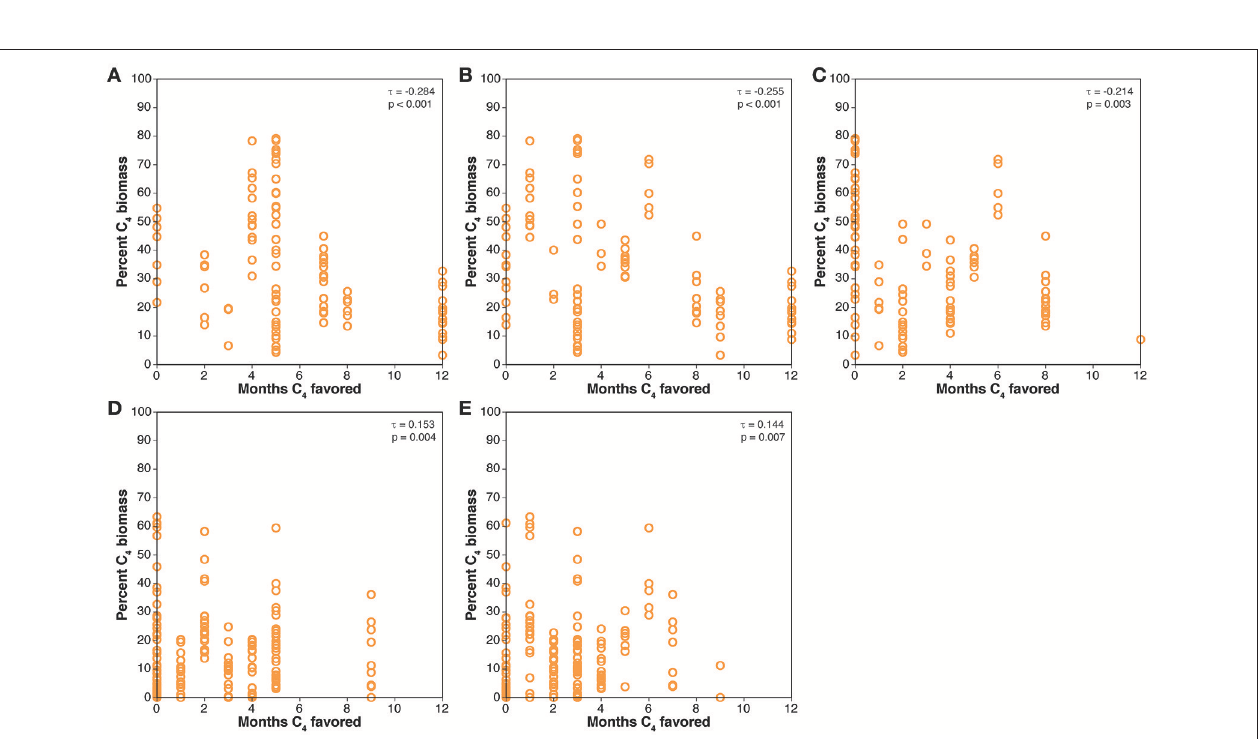
FIGURE 6 | Comparisons of results of the Collatz model to mean estimated percent C 4 biomass from the paleosol carbonate compilation. (A) Pliocene, 280 ppmV CO 2 . (B) Pliocene, 405 ppvM CO 2 . (C) Pliocene, 560 ppmV CO 2 . (D) Miocene, 280 ppmv CO 2 . (E) Miocene, 401 ppmV CO 2 .